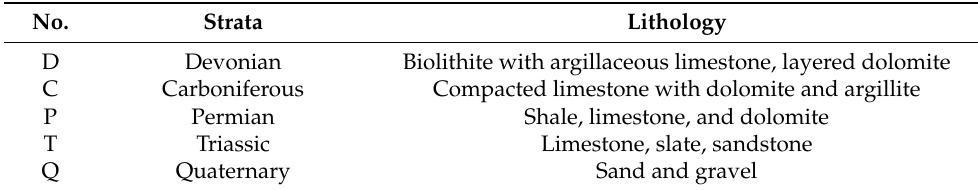
Table 1. Descriptions of lithologic characteristics and strata in the Jiuzhaigou area [8].